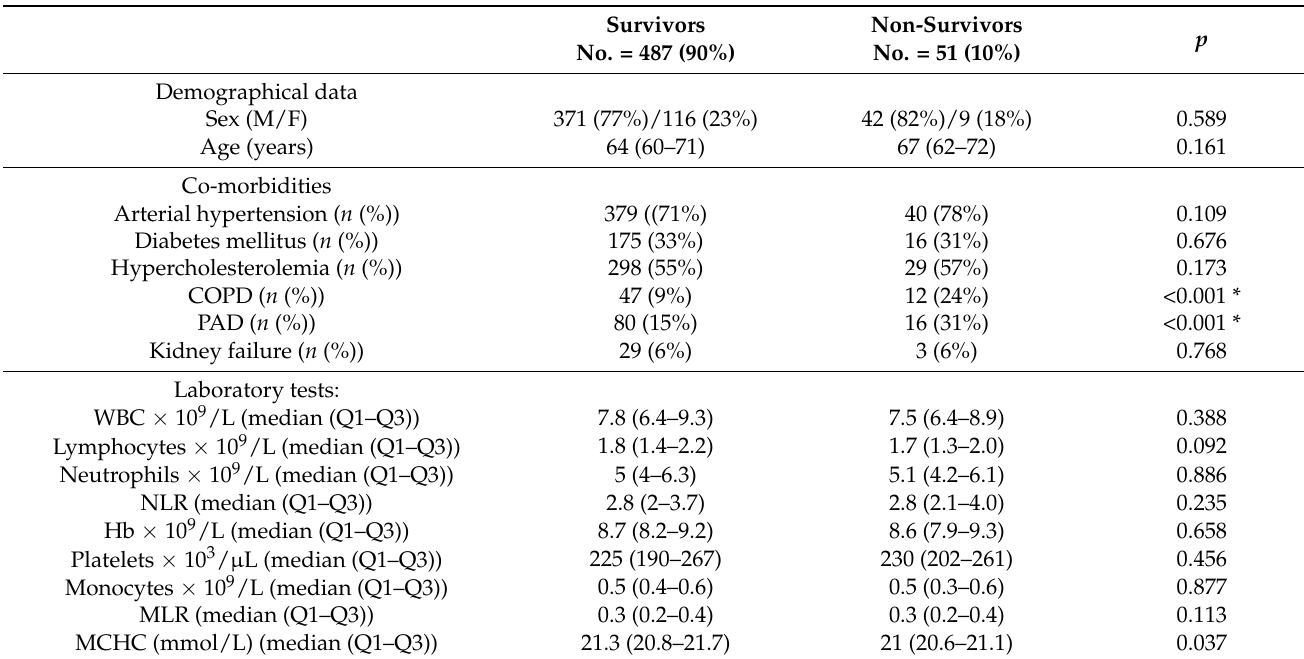
Table 1. Patient characteristics (demographical, clinical, and laboratory